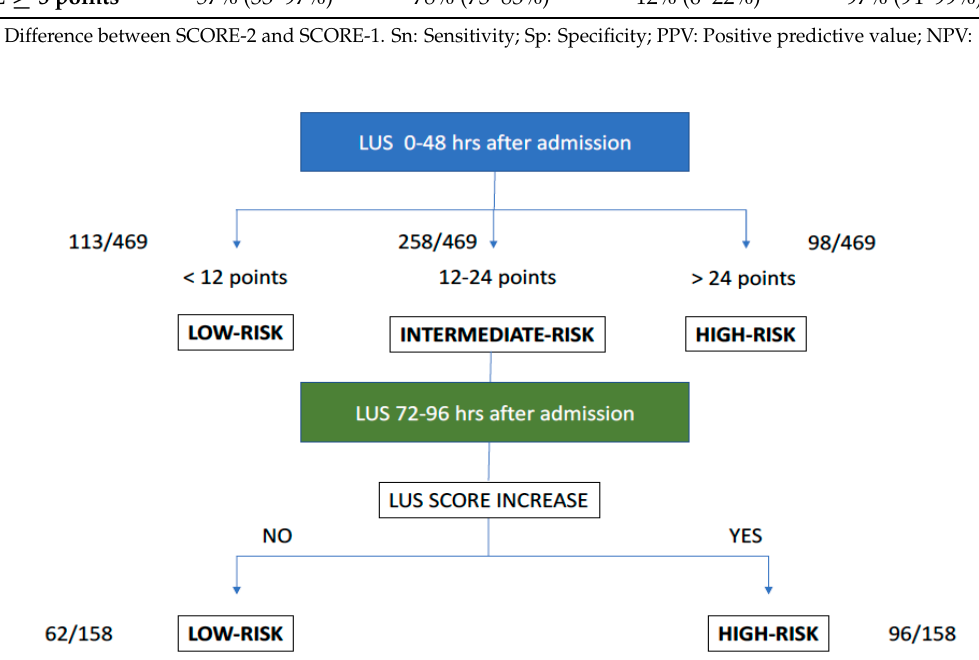
Figure 5. Suggested algorithm using serial LUS.